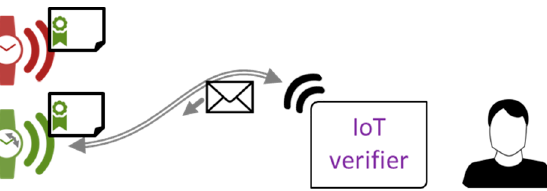
Figure 5. Physical identity verification for offline devices by user sending a nonce (shown as envelope). A malicious device (red) with stolen identity cannot know the number being sent.